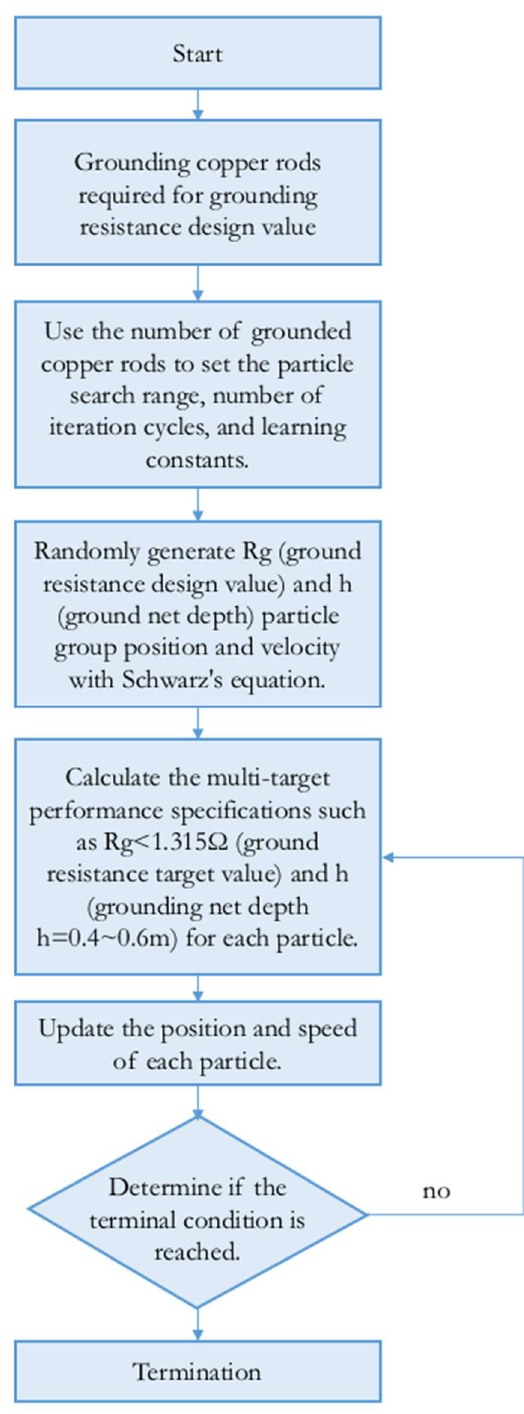
Figure 4. Flow of the grounding system with MOPSO.